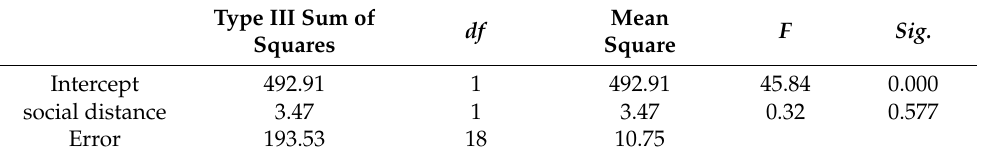
Table 13. Tests of Between-Subjects Effects of P2 amplitude (promotion